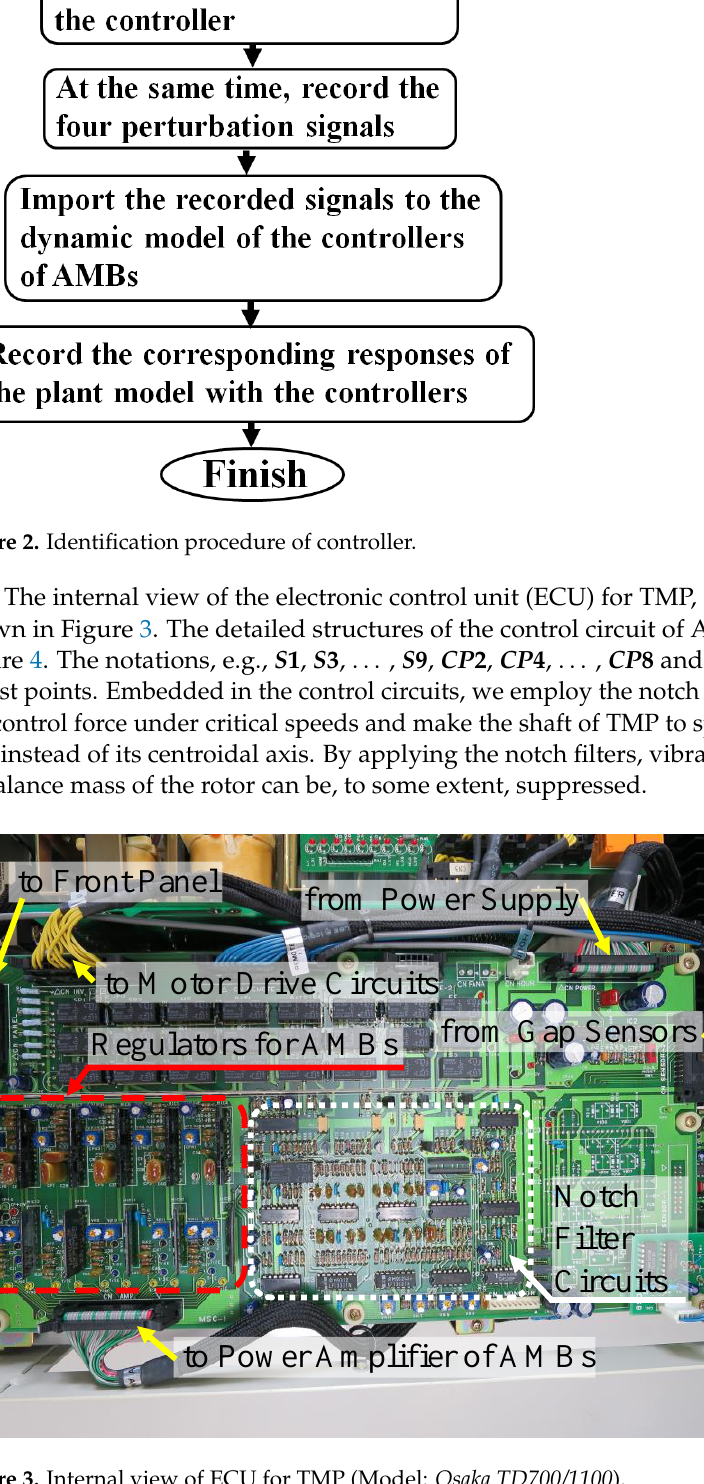
Figure 1. Control structure of rotor/AMB unit.